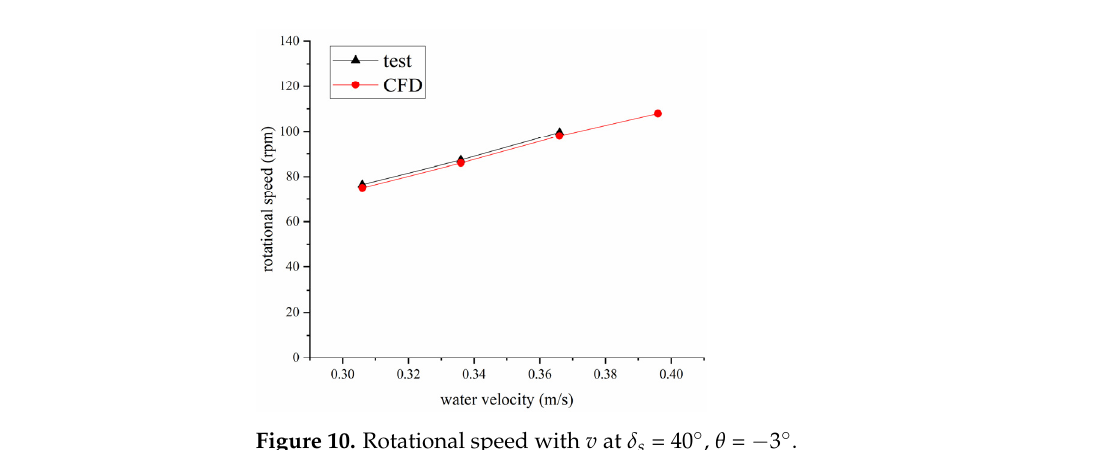
Figure 9. Rotational speed with 𝜃 at 𝛿 (cid:3046) = 40 ° , 𝑣 = 0.306 m/s . The variation of rotational speed with 𝑣 is shown in Figure 10. There is an apparent positive linear correlation between rotational speed and water velocity.